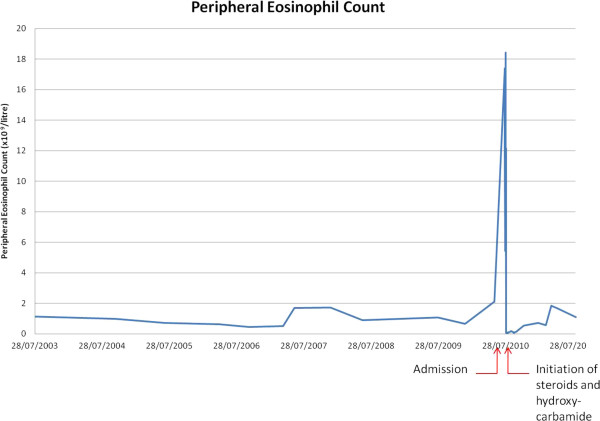
Dramatic reduction in Peripheral Eosinophil Count achieved with steroids and hydroxycarbamide.